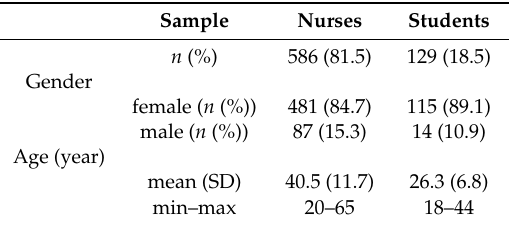
Table 1. Sociodemographic characteristics of the respondents ( n = 697).